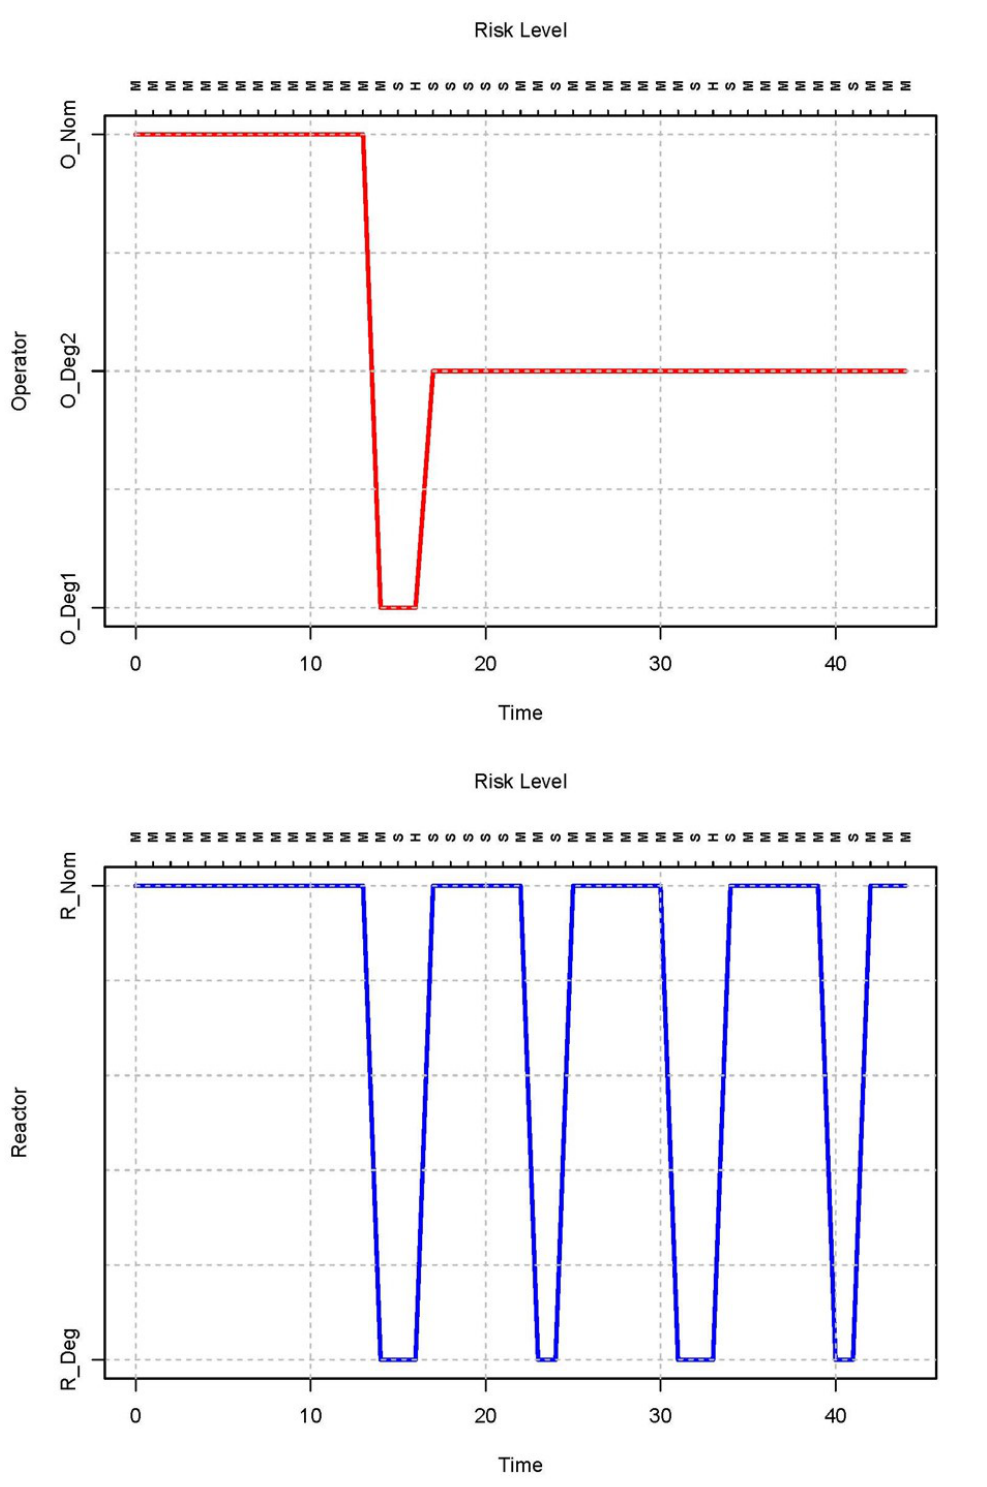
Figure 16. Agent’s behavioral modes with the related Risk Level during simulation